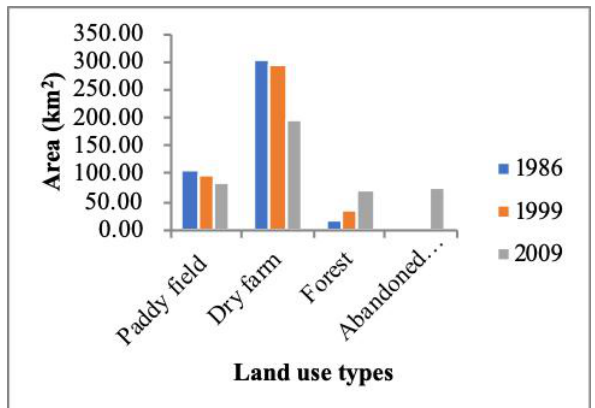
Figure 3 Area of paddy land, dry farm, forest and